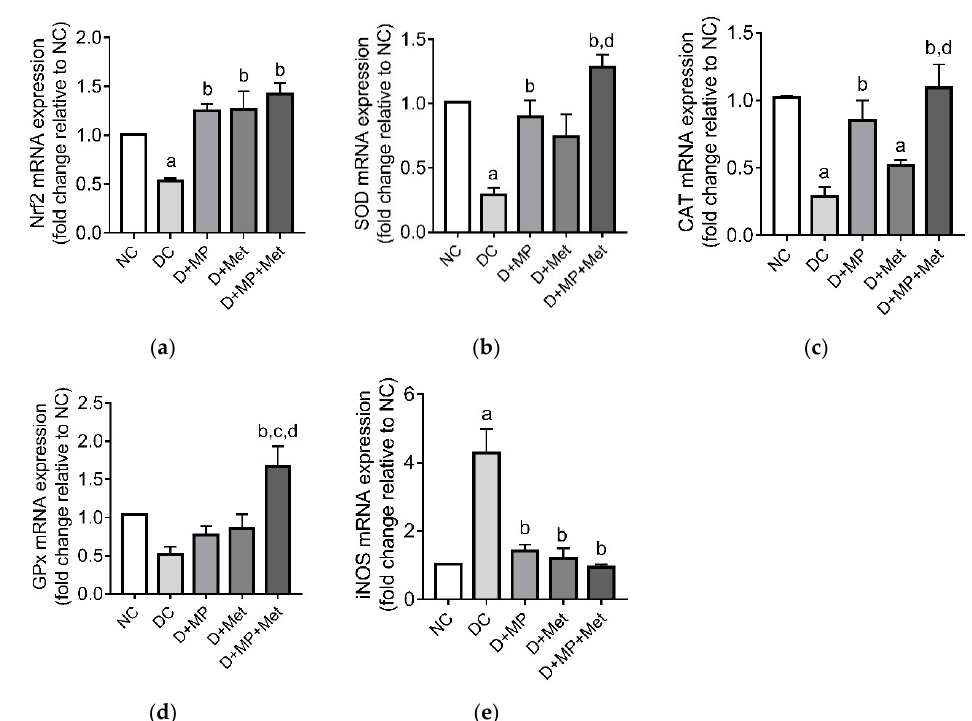
Figure 4. The effect of Malaysian propolis, metformin and their combination on testicular mRNA expressions of ( a ) Nrf2, ( b ) SOD, ( c ) CAT, ( d ) GPx and ( e ) iNOS in diabetic rats. Values are mean ± SD, n = 6. a p < 0.05 versus NC, b p < 0.05 versus DC, c p < 0.05 versus D+MP, d p < 0.05 versus D+Met